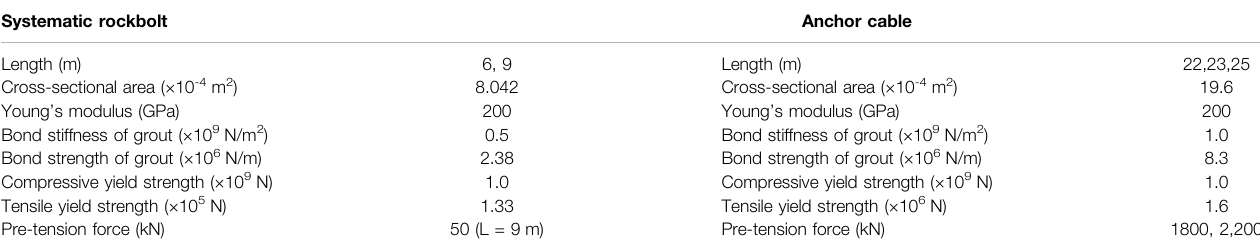
TABLE 4 | Input parameters for systematic supports. Systematic rockbolt